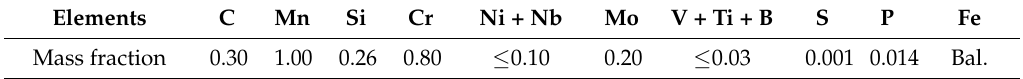
Table 1. Chemical composition of the test steel (wt